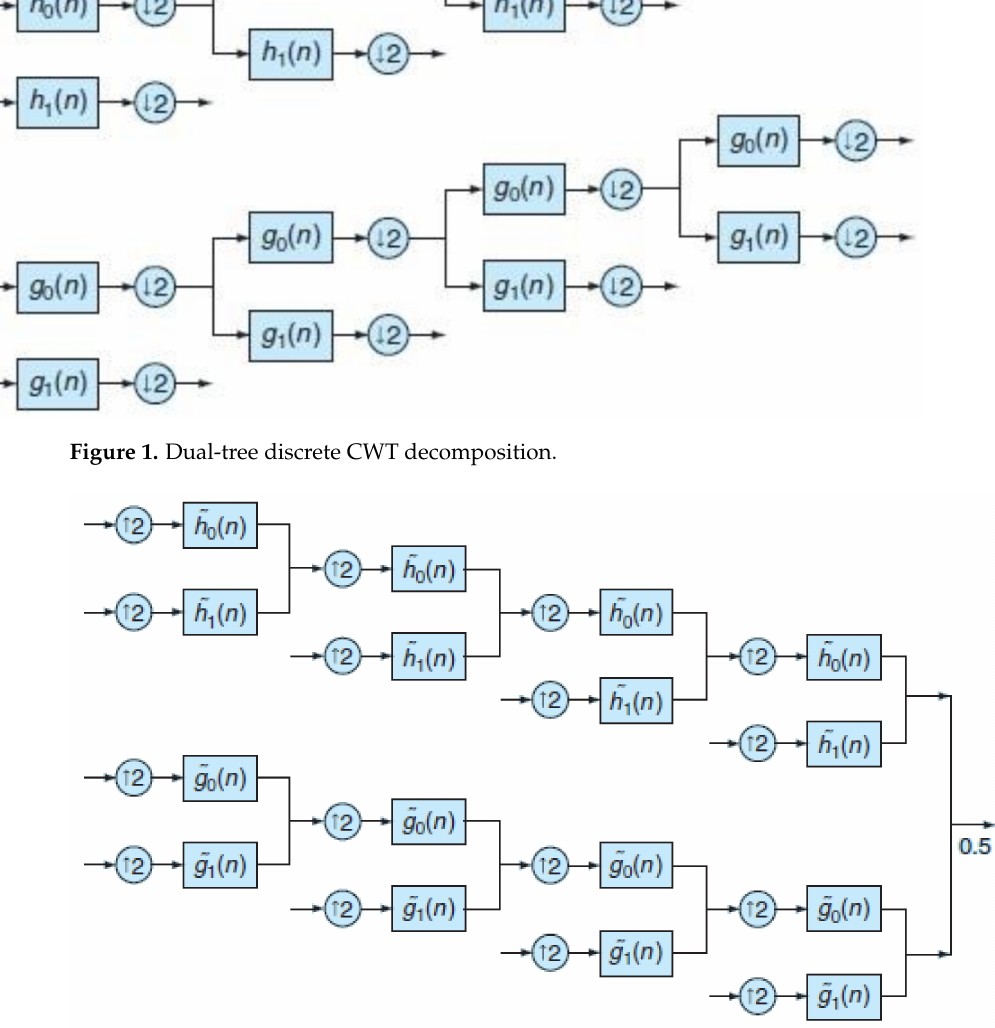
Figure 2. Synthesis for dual-tree